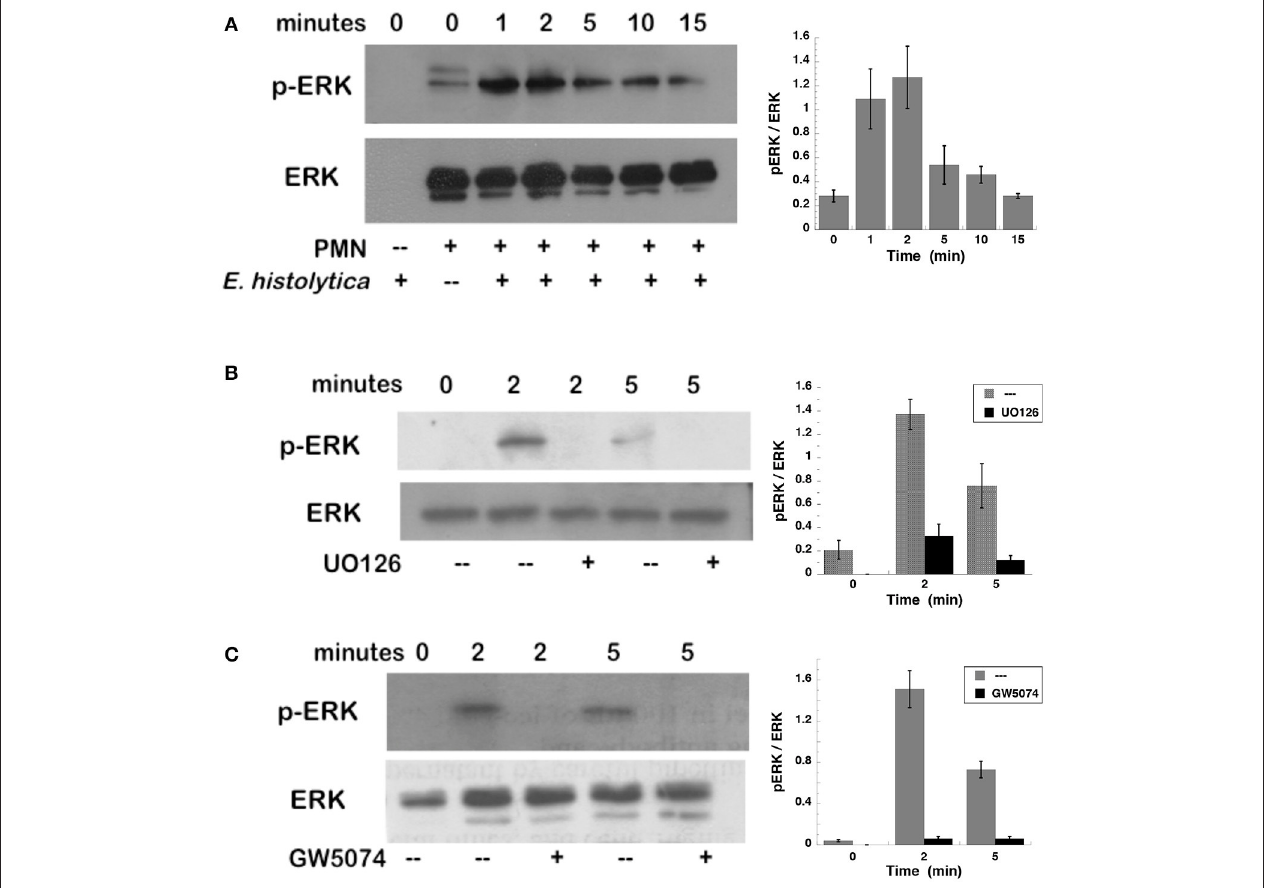
FIGURE 7 | Entamoeba histolytica induce activation of ERK. Human neutrophils were stimulated with E. histolytica trophozoites for various periods of time, and then cell lysates were prepared. Neutrophils were (A) left untreated, or previously treated with (B) the MEK inhibitor UO126 (75 µ M), or with (C) the Raf inhibitor GW5074 (100 µ M). Proteins were resolved by SDS-PAGE, and then Western blotted for phosphorylated-ERK (p-ERK) (upper panel) or for total ERK (lower panel) to show equal loading of proteins. Plots on the right show densitometric analysis for the ratio of pERK/ERK. Data are mean ± SEM of three